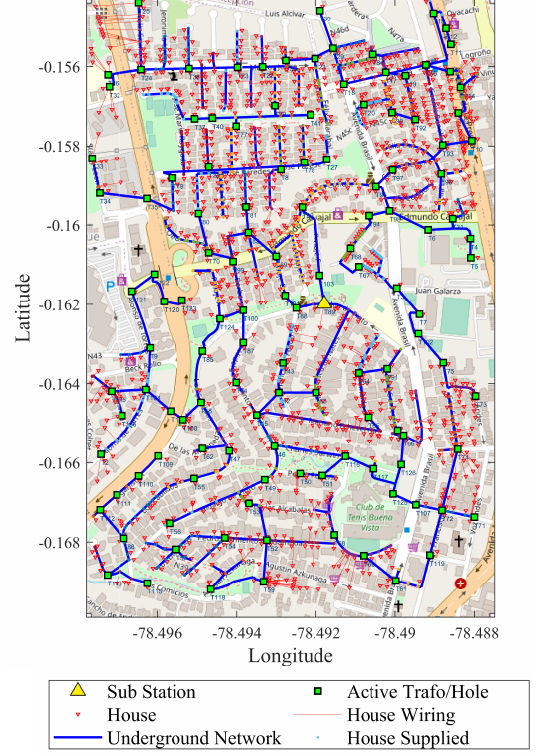
Figure 6. Optimal location of transformers and manhole on the geographic area-Quito Tenis. The radial topology connecting all the chosen sites has been obtained through MST techniques and Haversine distance calculation. Furthermore, the shortest connection distances have been routed along the trajectory of the streets existing in the geographical area to form the underground network trench route. Figure 7 shows the radial topology for the underground network in the geographical location.